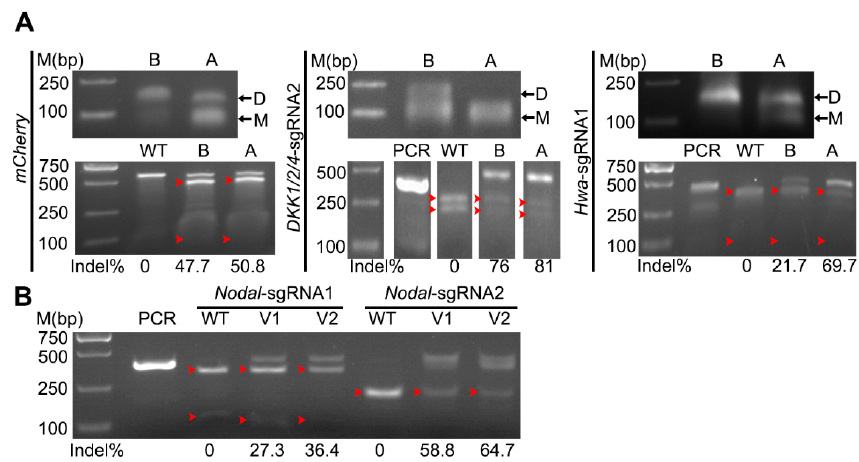
Figure 3. Improvement of mutation efficiency of Cas9/sgRNA in amphioxus. The induced mutation ratios shown under each gel image were estimated by either a T7 endonuclease assay (for mCherry - sgRNA) or a restriction endonuclease assay (for sgRNAs targeting the Dkk1/2/4 , Nodal and Hwa genes). Red arrowhead indicates bands released by endonuclease digestions. PCR, PCR products not treated with the restriction enzyme; WT, digestion of PCR products from control (uninjected) embryos with the restriction enzyme. ( A ) Monomerization of sgRNAs (top) and its effect on mutation efficiency (bottom) . sgRNA was monomerized using a denaturing step. B, before denaturation; A, after denaturation; D, dimer, M, monomer. ( B ) Comparison of mutation efficacies between version 1 (V1) and version 2 (V2) sgRNAs targeting the Nodal gene.